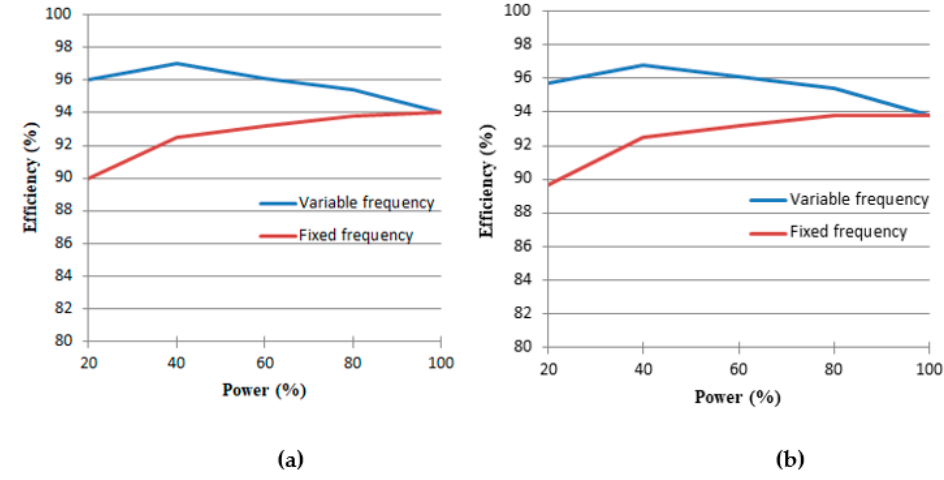
Figure 14. Efficiency performance with fixed switching frequency and variable switching frequency in TCM operation: ( a ) forward direction; ( b ) reverse direction.